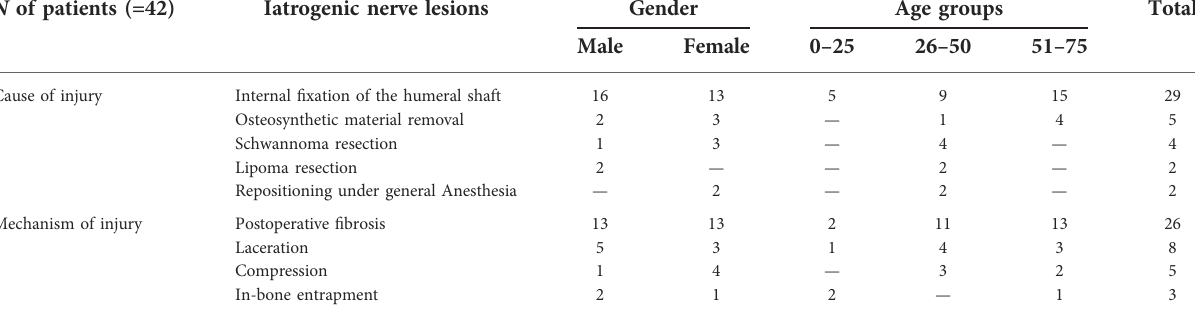
TABLE 6 Causes and mechanisms of iatrogenic radial nerve injuries. N of patients